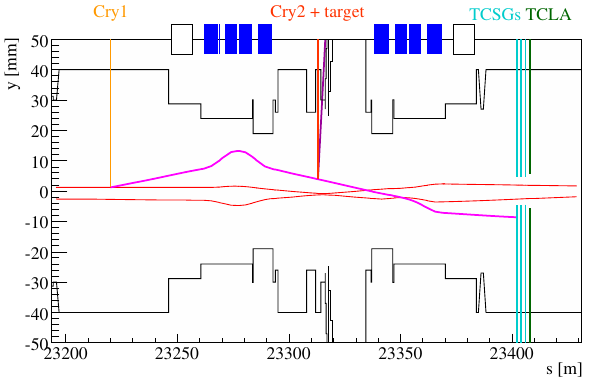
Fig. 2 Trajectory of channeled halo particles and mechanical aperture of the beam pipe (black) versus longitudinal position along the IR8 insertion. The first crystal, shown by the light orange line, sits on the 5 σ beam envelope shown by the red lines. The assembly of target plus second crystal, shown by the dark orange line, is placed at about 2.4 m upstream of IP8 in the Beam 1 direction and intercepts halo particles channeled by the first crystal (light magenta line). The trajectory fol- lowed by particles channeled also by the second crystal is shown by the dark magenta line. The TCSGs and TCLA used to intercept chan- neled halo particles are represented in cyan and green lines and are set at 10 σ and 13 σ , respectively. The magnetic lattice is also reported on top, where blue and white boxes represent main superconducting quadrupoles and dipoles,